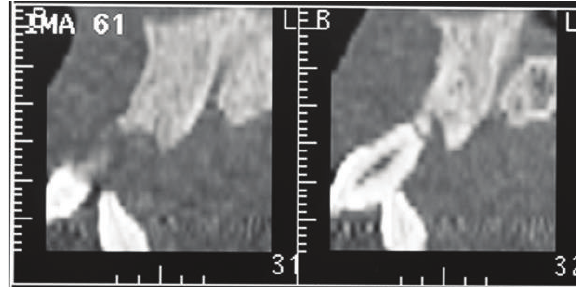
Figure 5: CT scans of patient upon presentation showing resorption of buccal and palatal bone adjacent to maxillary